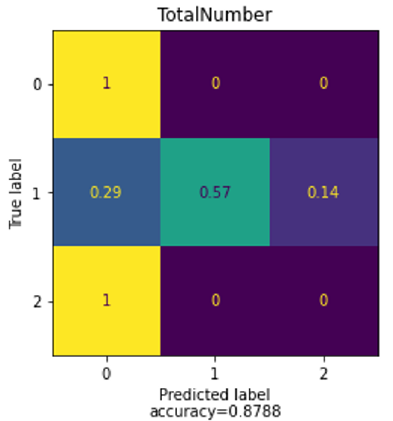
Figure 11. Confusion Matrix of Random